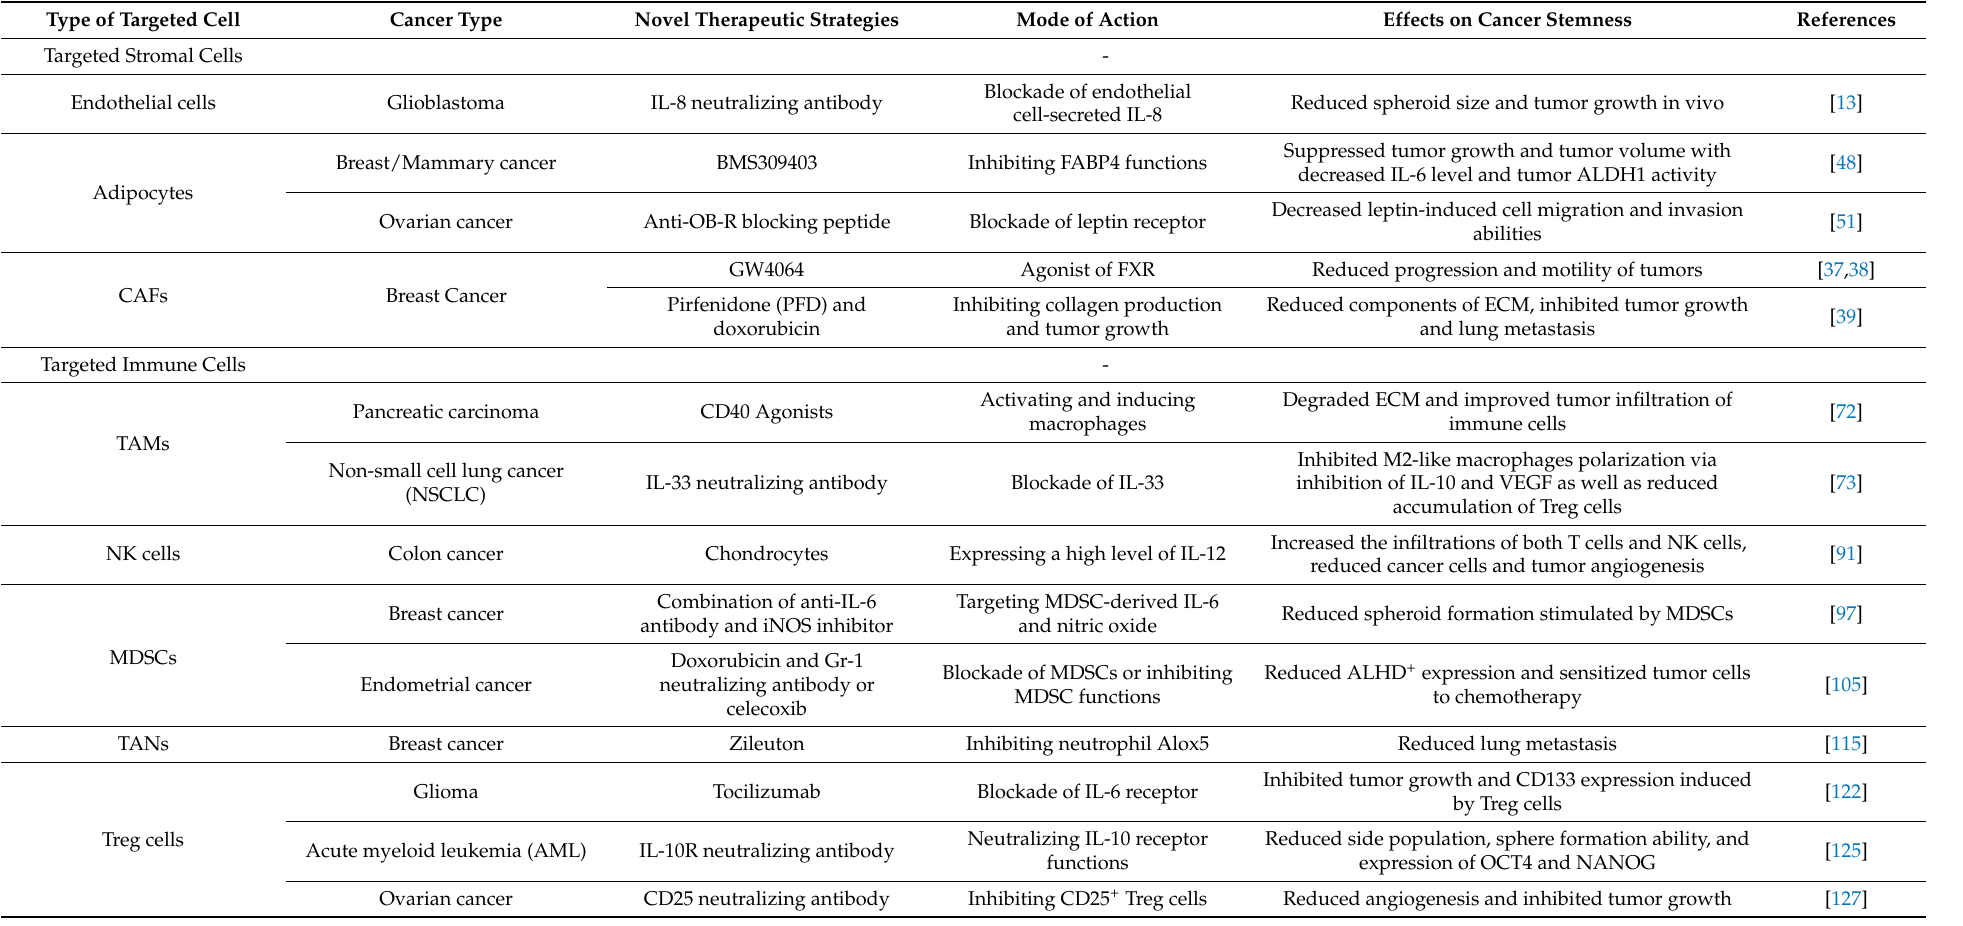
Table 1. Therapeutic strategies targeting the interactions between CSCs and stromal cells for cancer